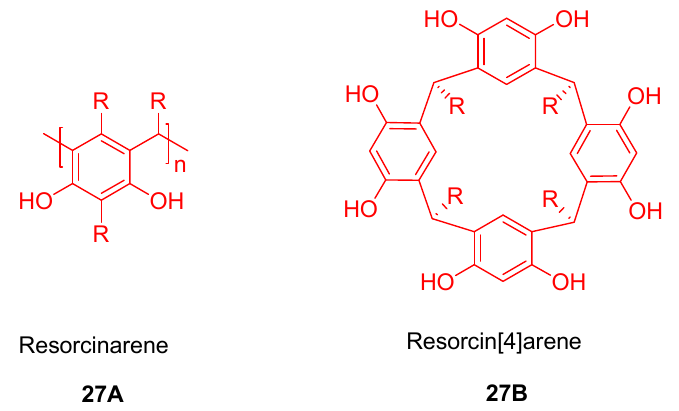
Figure 28. Schematic representation of resorcin[n]arene ( 27A ) and resorcin[4]arene ( 27B